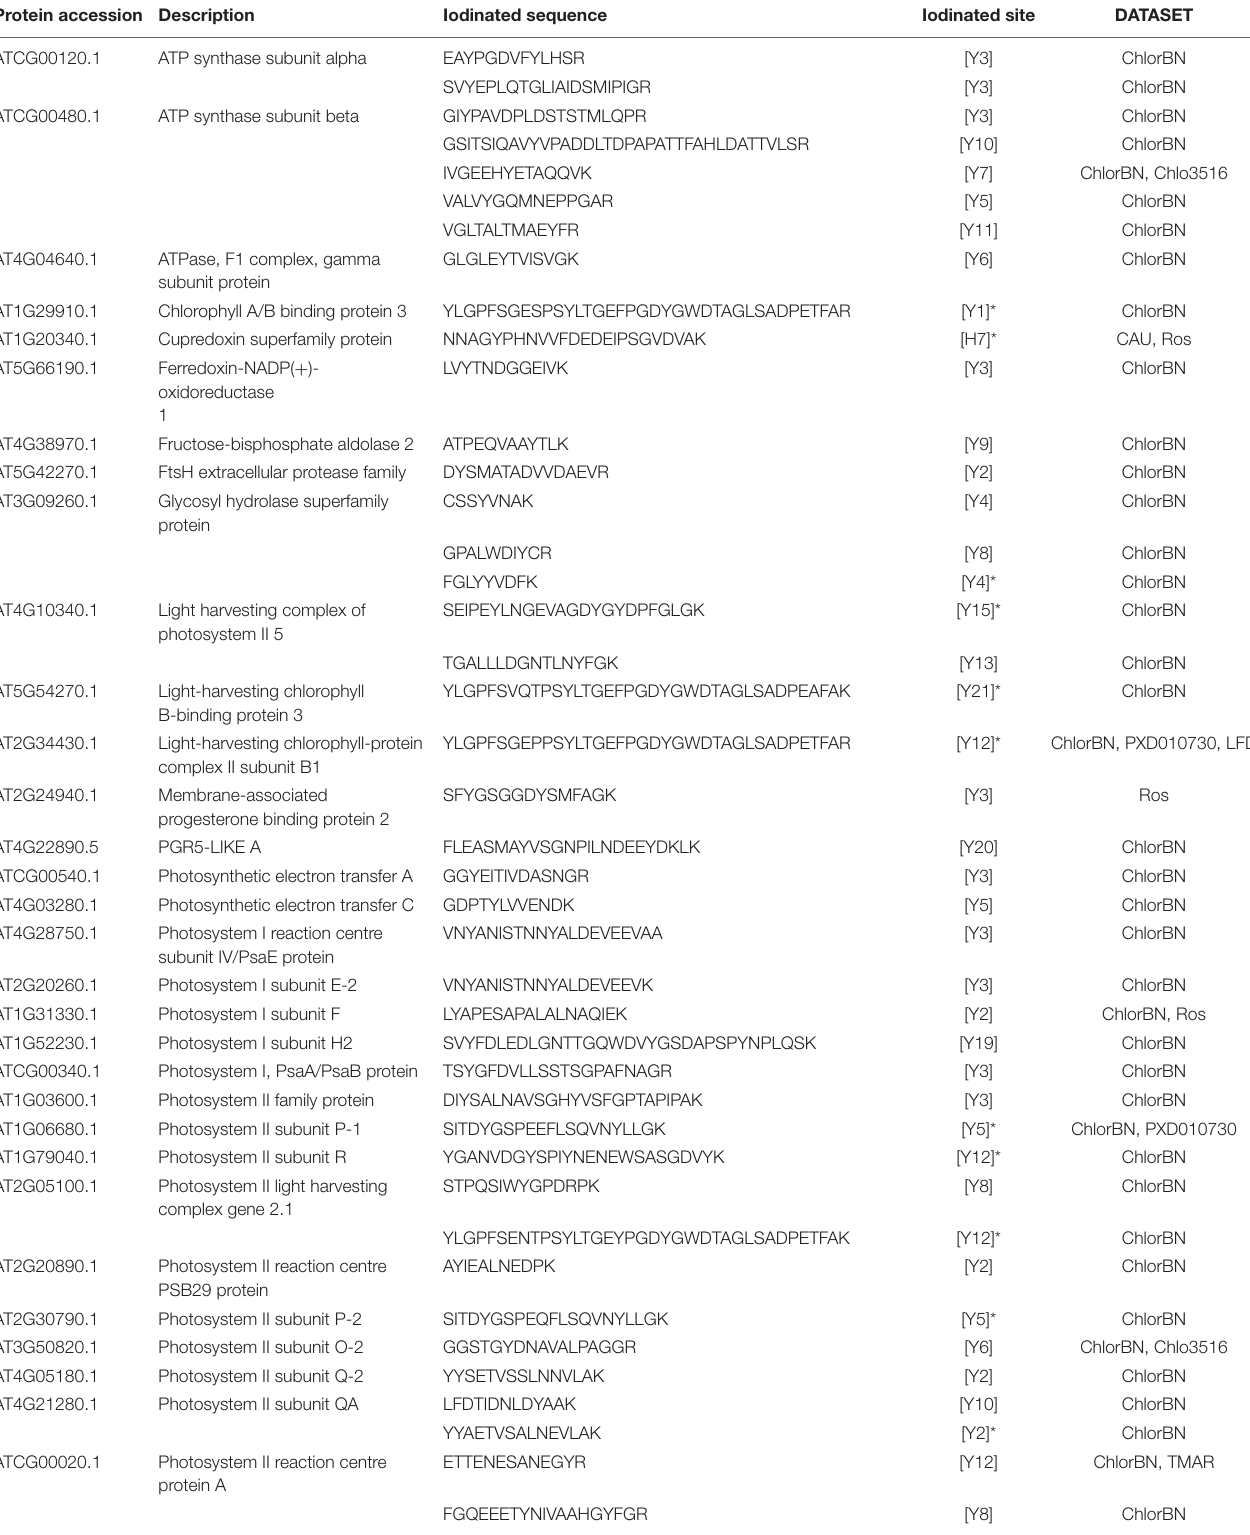
TABLE 1 | Iodinated peptides identified in A. thaliana leaves (chloroplast, cauline, and rosette) by database searching of mass spectrometric data retrieved from PRIDE repository. Protein accession